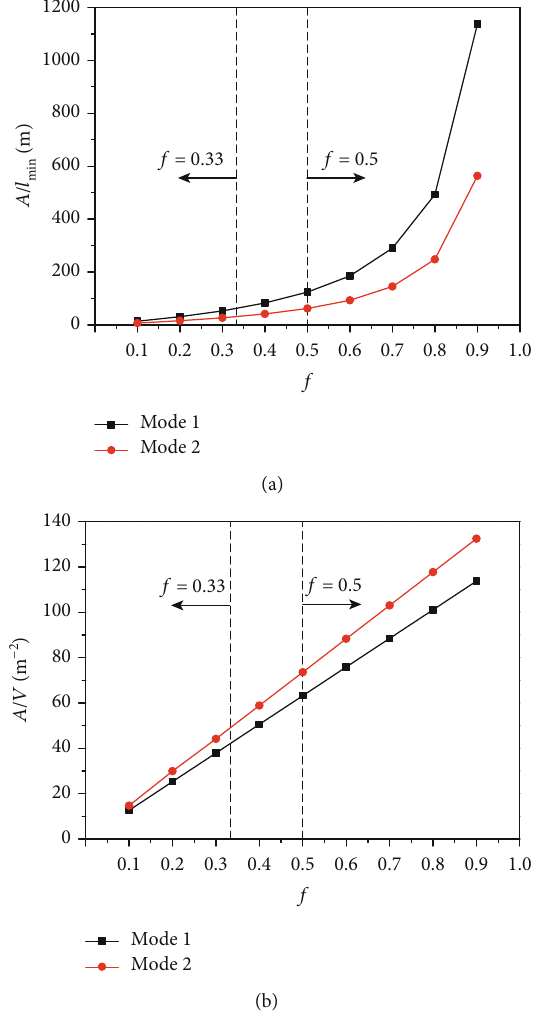
Figure 11: Ratio of the solar collector area to the sewage heat exchanger minimum length in di ff erent modes.